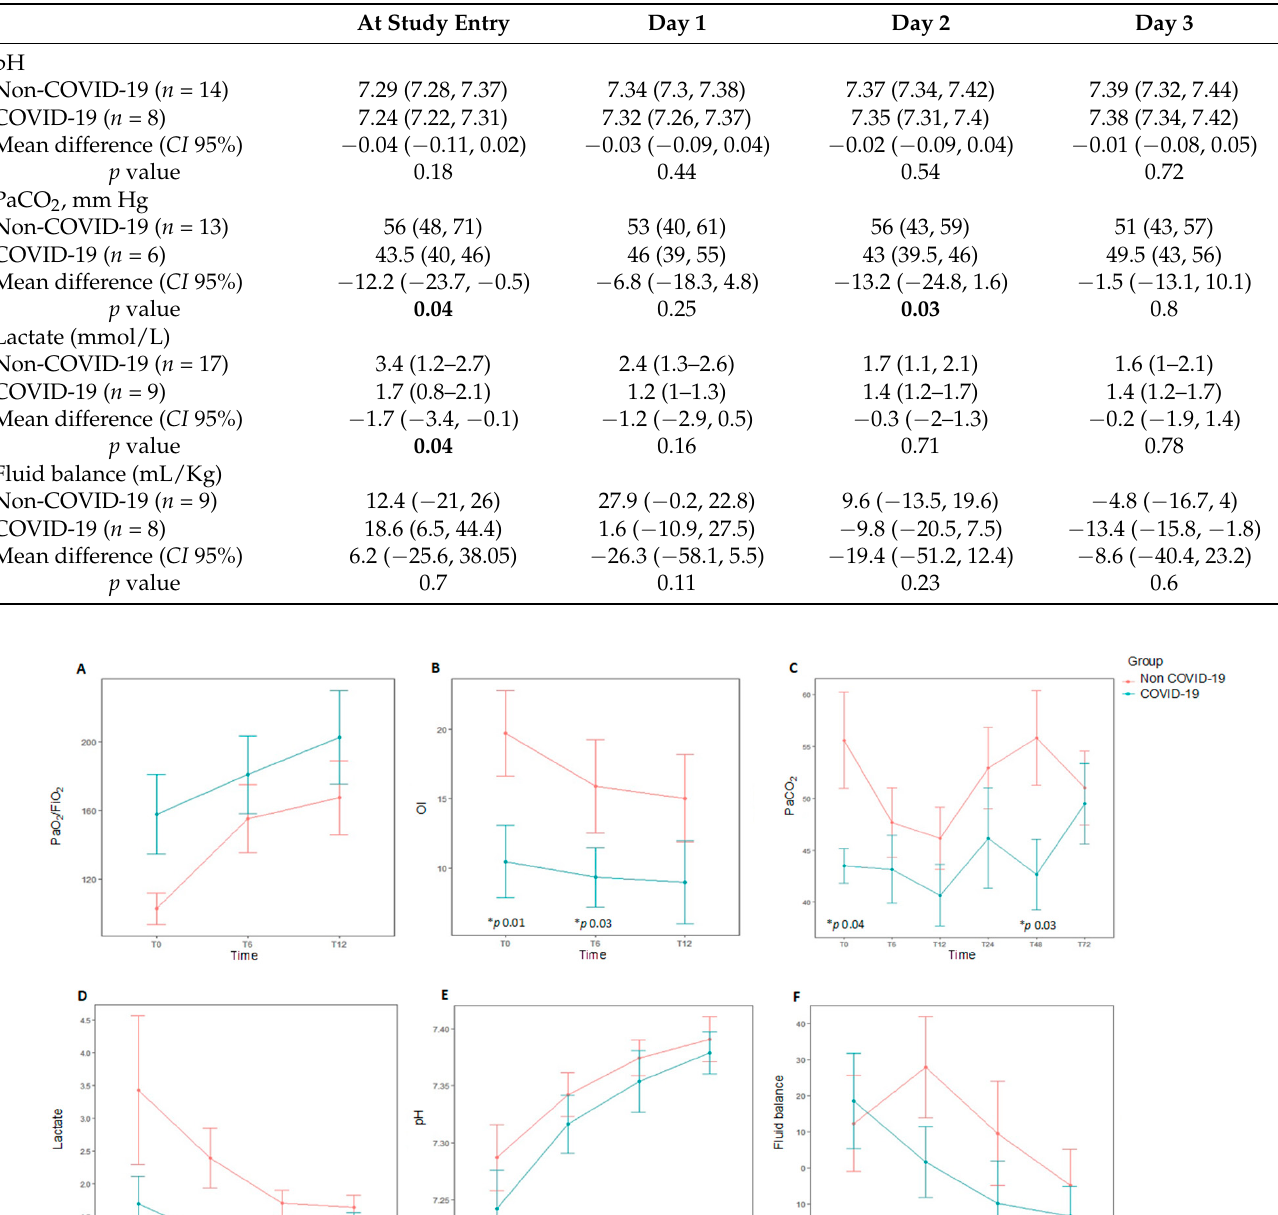
Table 2. Physiological outcomes (blood gas, hemodynamic data, and fluid balance) over time. Data collected during the first three days in the Pediatric Intensive Care Unit for the two cohorts of patients (COVID-19 and non-COVID-19).